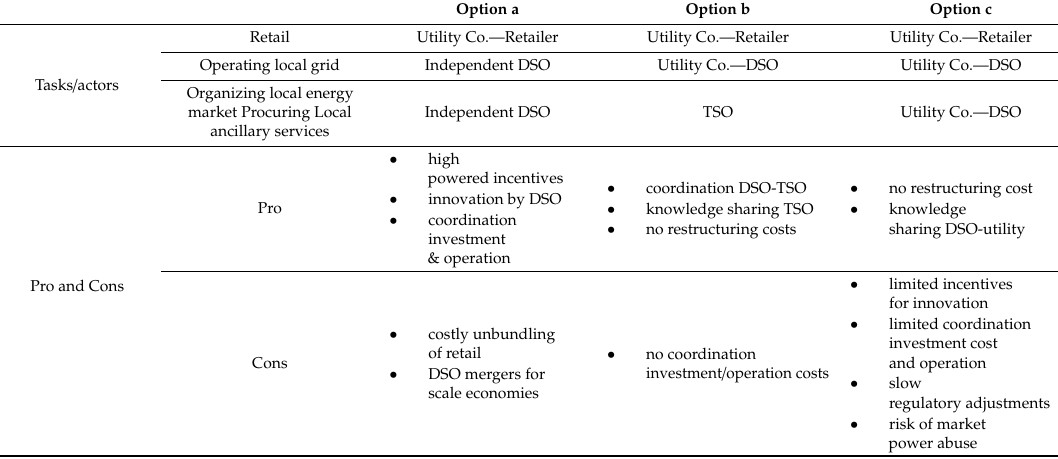
Table 1. Three options for organizing DSOs activities, and their benefits and drawbacks. Cells with the same color are operated by the same entity either directly or by a